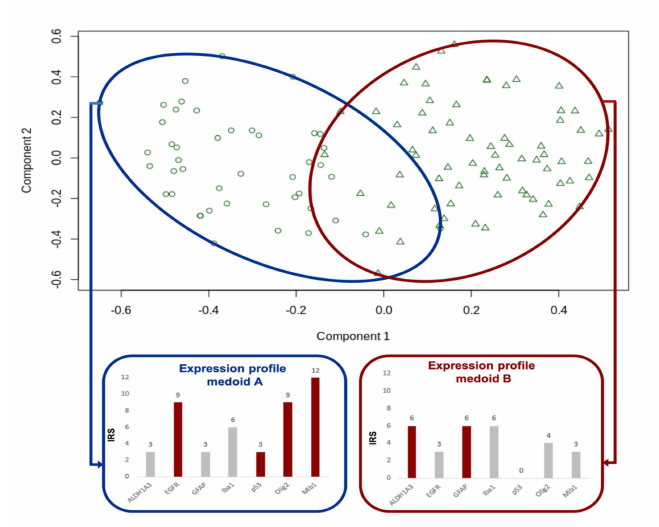
Figure 3. PAM divides the tumor areas into two subtypes. Similar to Figure 2, the blue frame is used for the classical subtype, the red for the mesenchymal